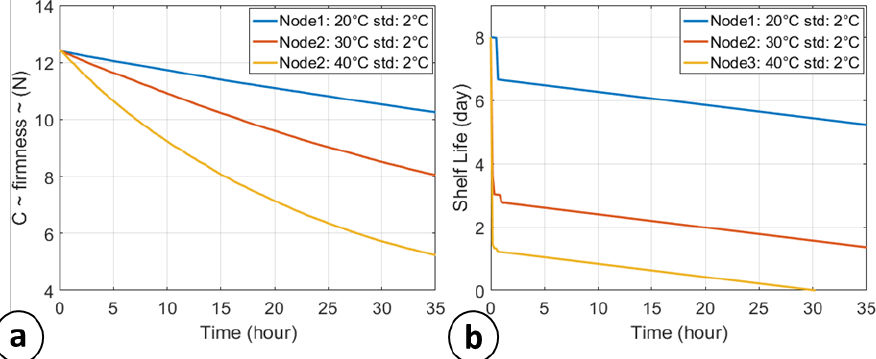
Figure 4. Food quality decay: ( a ) changes in the quality factor c (firmness [N]) of tomato stored at different temperatures. ( b ) Shelf life modulation of tomatoes at different temperature.